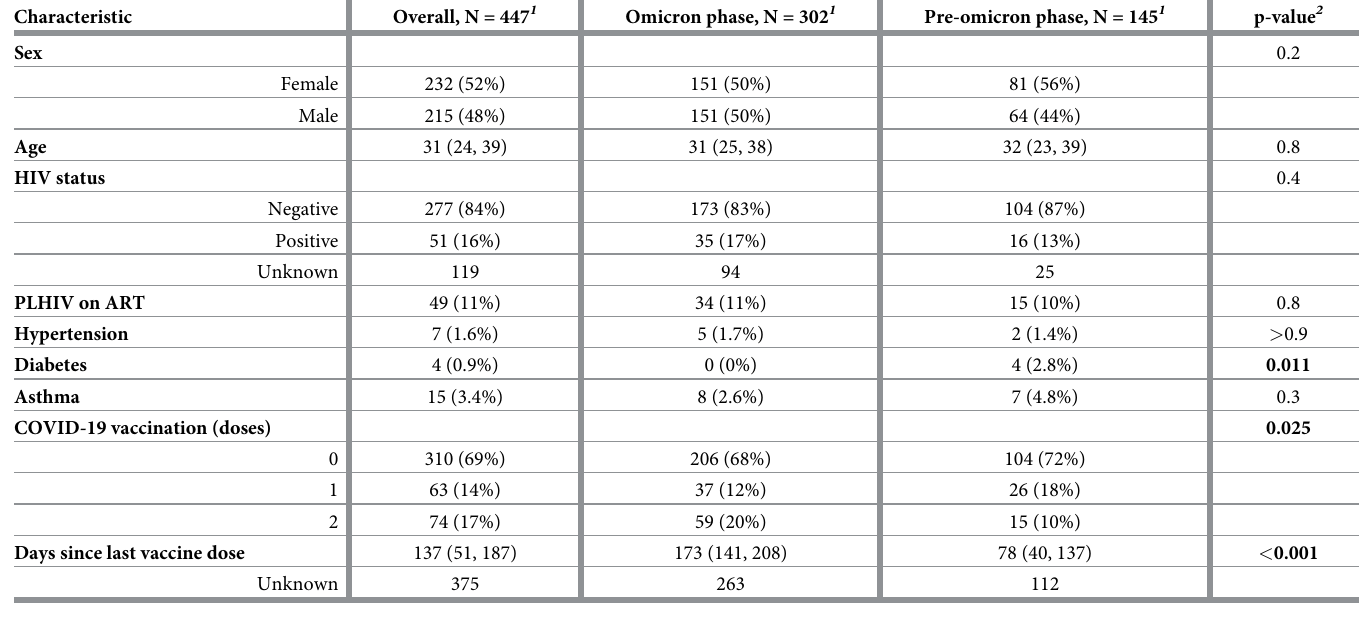
Table 3. Participant characteristics for PCR-confirmed SARS-CoV-2 infected adult